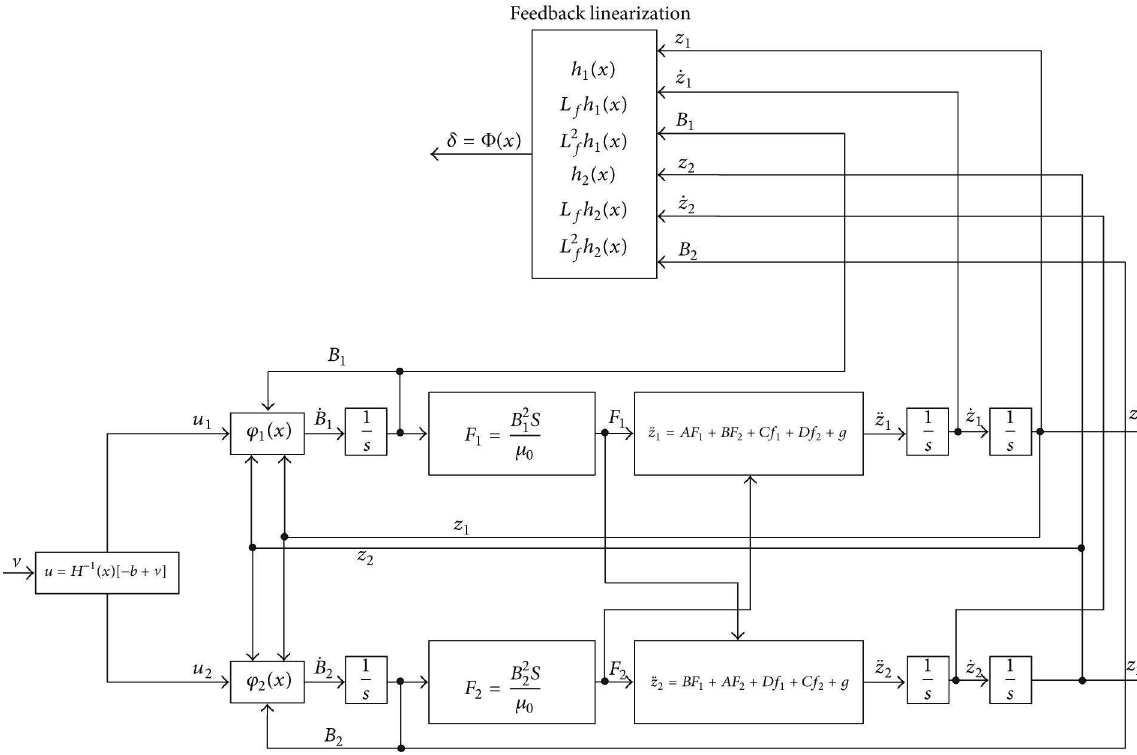
Figure 3: Double suspension points’ control construction diagram with feedback linearization.